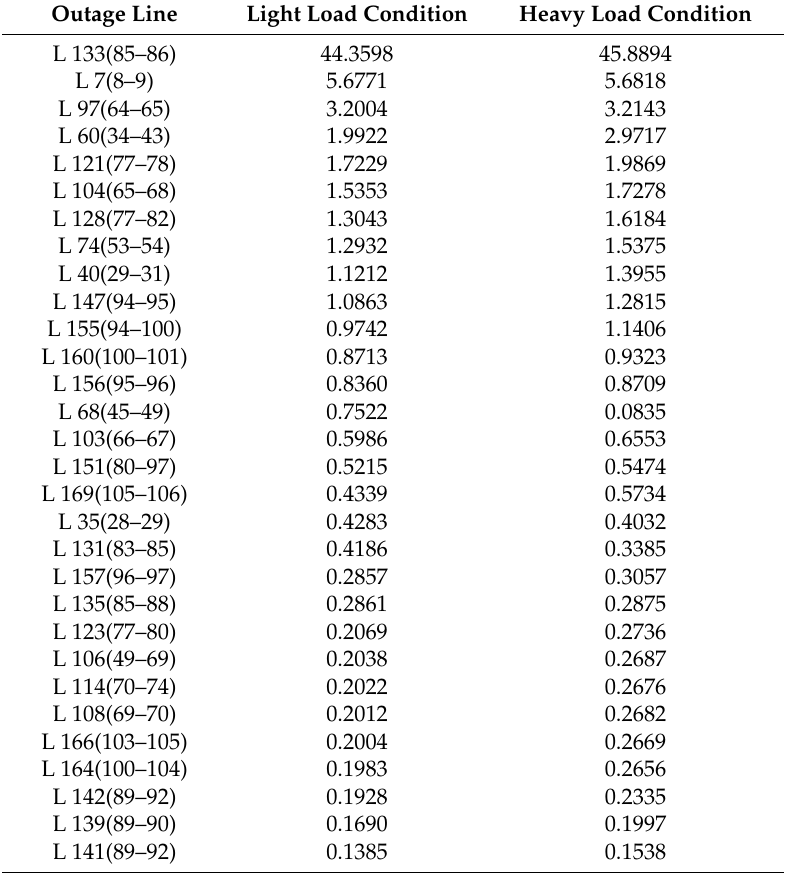
Table 14. Security index results of light and heavy load conditions of the IEEE 118-bus